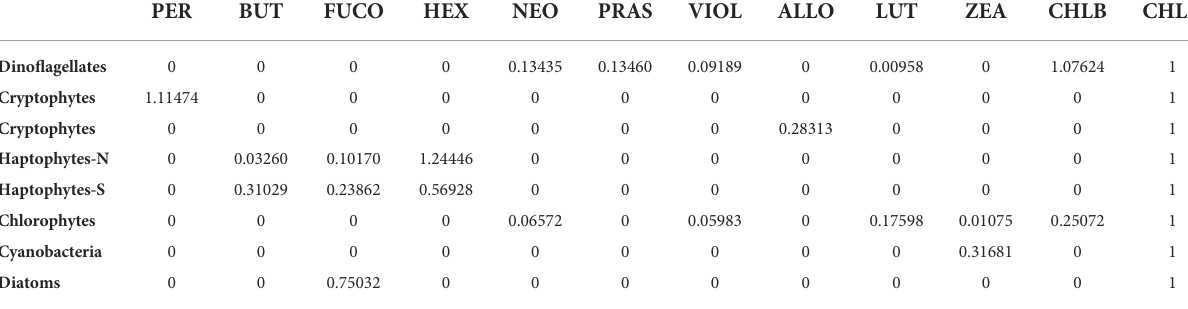
TABLE 1B Final CHEMTAX pigment